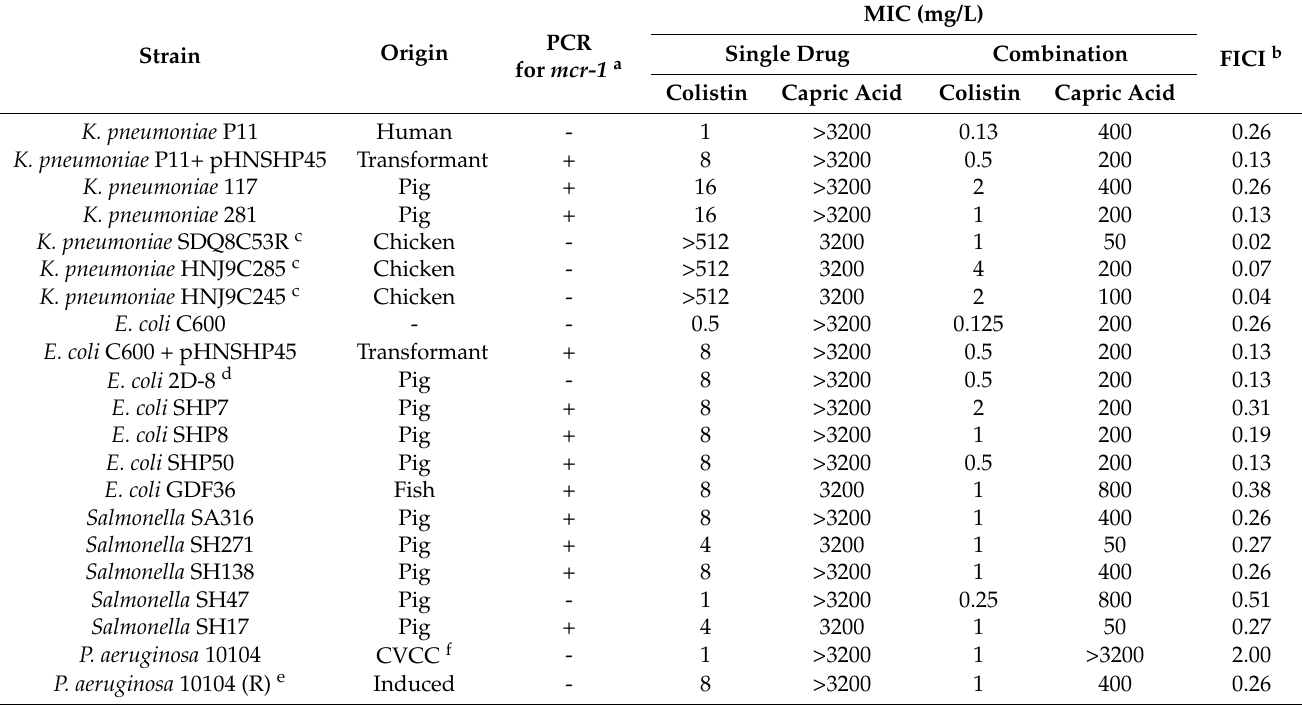
Table 1. FICI and MIC (mg/L) values for the strains tested in this study.